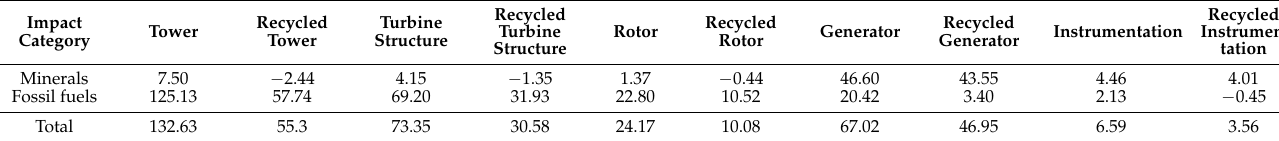
Table 6. Results of grouping and weighting—resources (unit: Pt/1